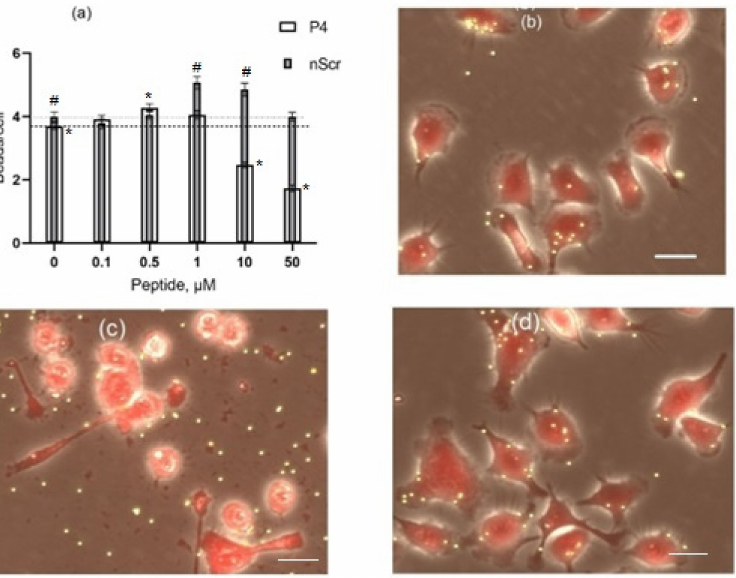
Figure 4. The effects of peptides P4 and nScr on cultured macrophages IC-21. ( a ) Dose-dependent effects of peptide P4 (white columns) and peptide nScr (gray columns) on cholesterol-dependent binding of 2- µ m fluorescent beads by macrophages; error bars, SE; *, # the difference from the control value is statistically significant at p ≤ 0.05 (*, P4; #, nScr). The dashed line shows the control level for P4 and the dotted line, for nScr. ( b – d ) Micrographs of cells under control conditions ( b ), after incubation with 50 µ M of peptide P4 ( c ), and with 50 µ M of peptide nScr ( d ). The cytotoxic effect of 50 µ M of peptide P4 can be seen in ( c ): all the cells are fragmented, the nuclei are contrasted, and most cells are retracted and have a rounded shape. Scale bar for ( b – d ) is 20 µ